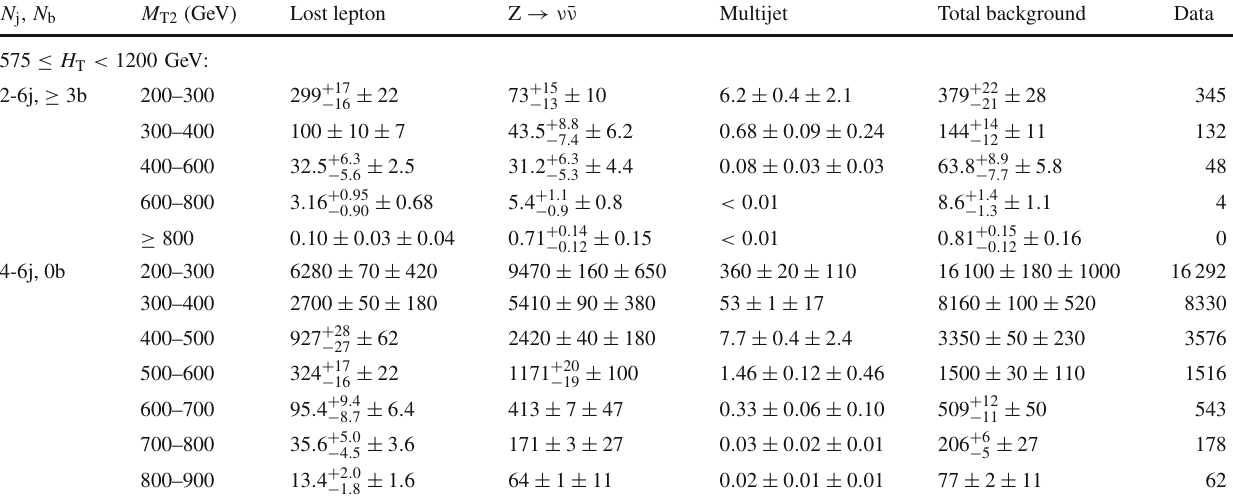
Table 17 Predictions and observations for the 26 search regions with 575 ≤ H T < 1200 GeV, and 2 ≤ N j ≤ 6 and N b ≥ 3, or 4 ≤ N j ≤ 6. Foreachofthebackgroundpredictions,thefirstuncertaintylistedissta-